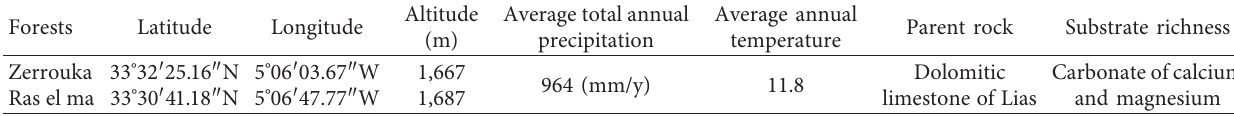
Table 1: Environmental conditions of sampled soils of Quercus ilex L.